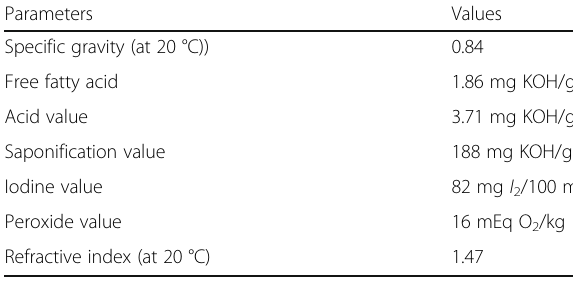
Table 6 Physicochemical properties of essential